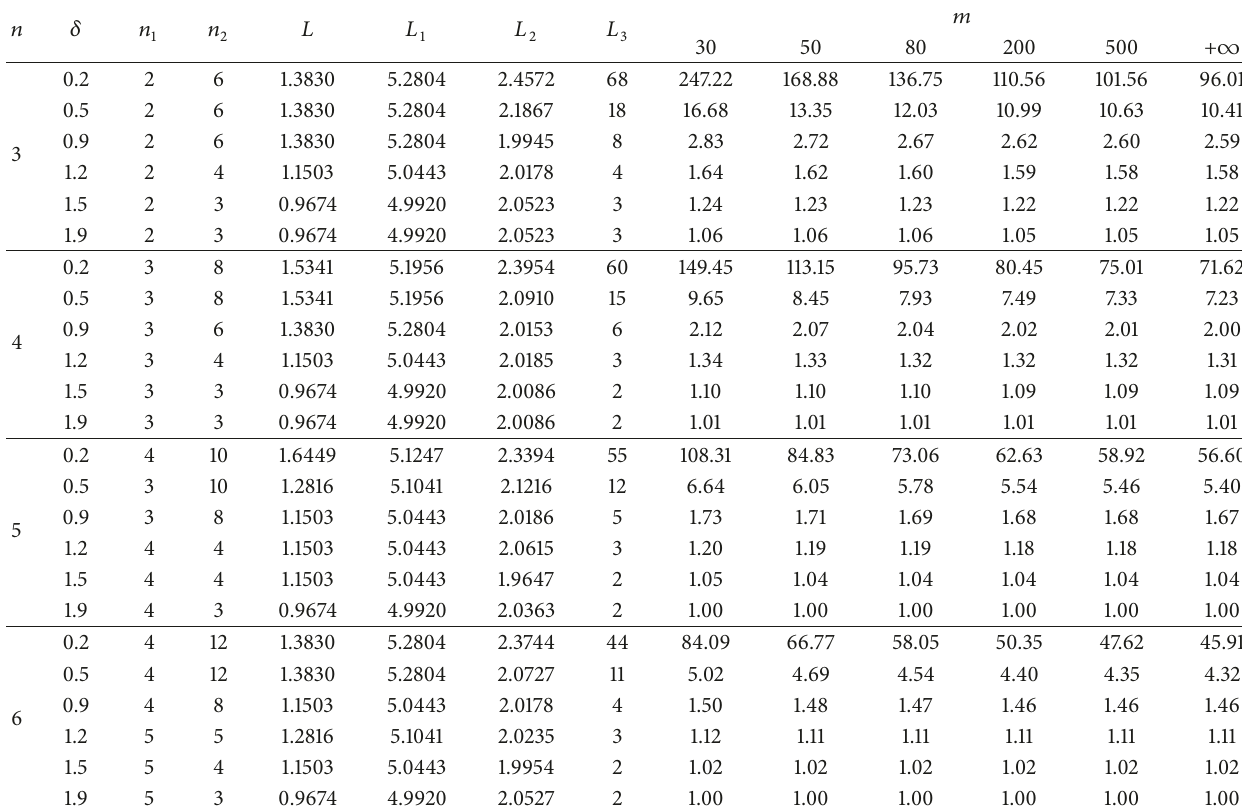
Table 2: Optimal charting parameters (𝑛 1 , 𝑛 2 ,𝐿,𝐿 1 ,𝐿 2 ,𝐿 3 ) and the corresponding ARL 1 s for 𝑛 = {3,4,5,6} with different combinations of (𝑚,𝛿) when ARL = 370.4 0